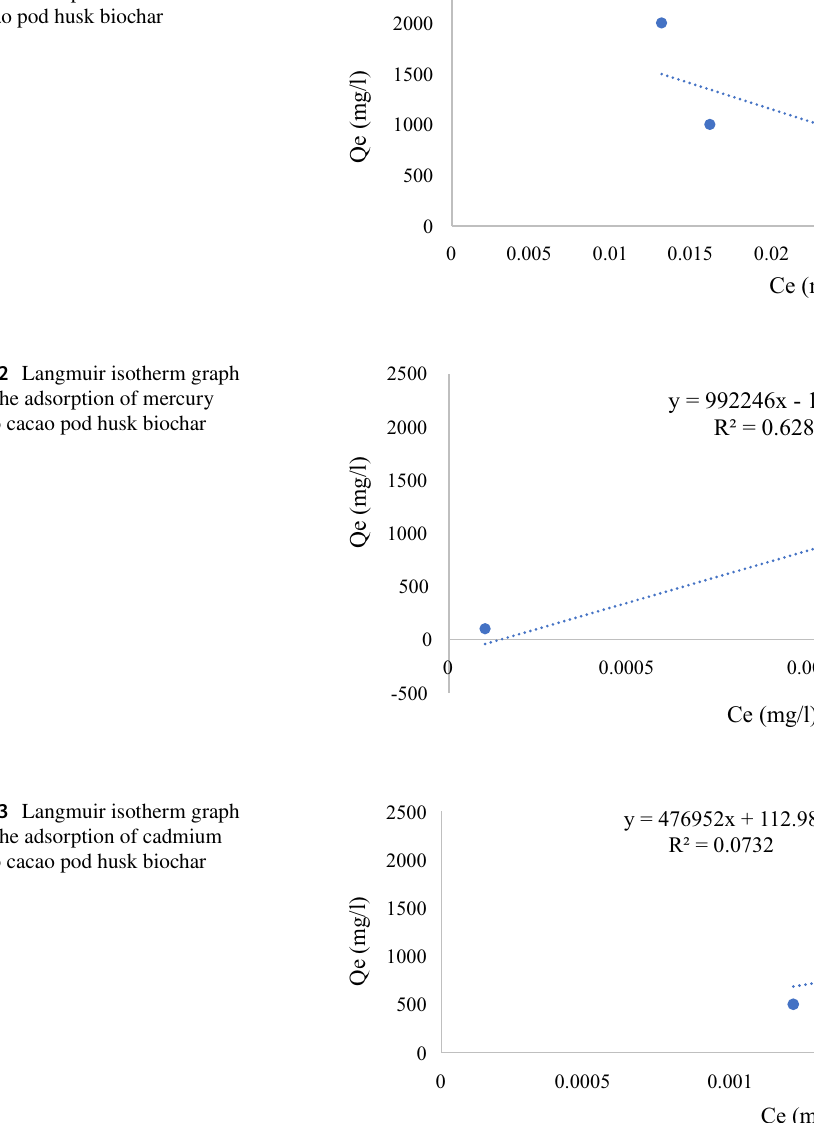
Fig. 1 Langmuir isotherm graph for the adsorption of lead onto cacao pod husk biochar